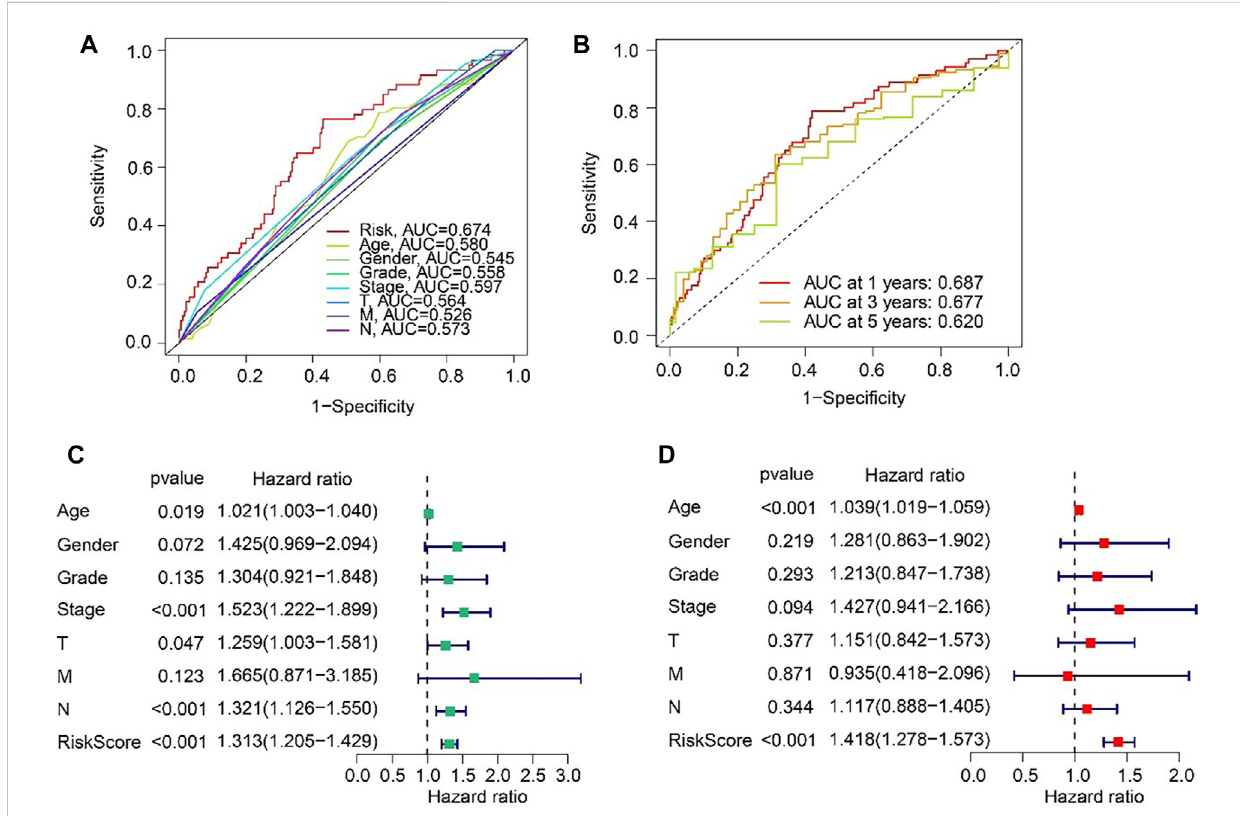
FIGURE 5 Independent prognosis analysis based on the ARLs prognostic signature and clinicopathological characteristics. (A) ROC curve shows the AUC of ARLs prognostic signature and other clinicopathological characteristics. (B) Time-dependent ROC curve shows the AUC at 1-, 3-, and 5-years. (C) Univariate Cox regression analysis. (D) Multivariate Cox regression